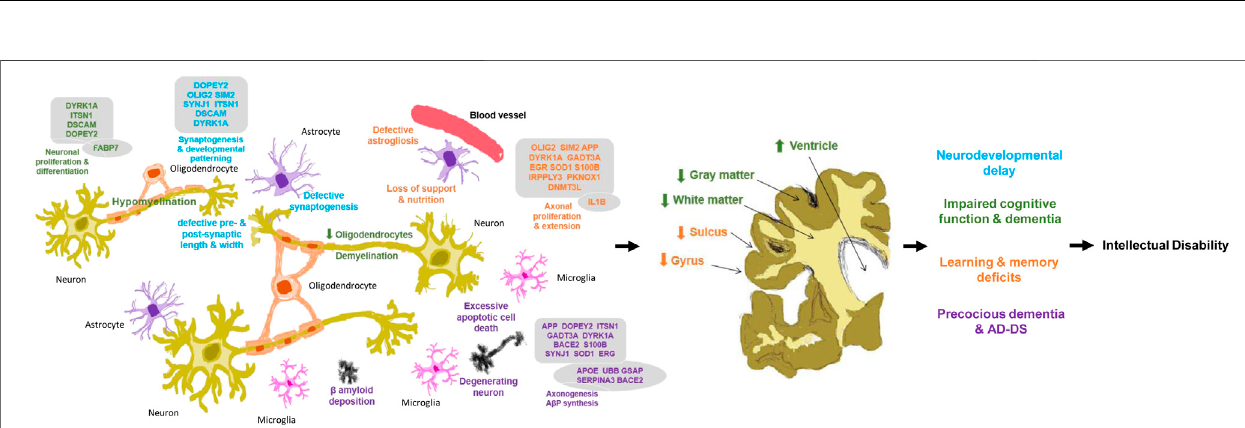
FIGURE 5 | Molecular networks in human Down syndrome brains. (A) Network of studied brain development genes in chromosome 21 (Chr21) in brains with DS. (B) Network of studied brain development genes in Chr21 (gene names in black) together with non-chromosome 21 (non-Chr21, gene names in red) in brains with DS Different color circles and lines represent the groups of genes with similar gene functions and interactions in metabolic pathways, physical interactions, gene co- expression or sharing their protein domains.